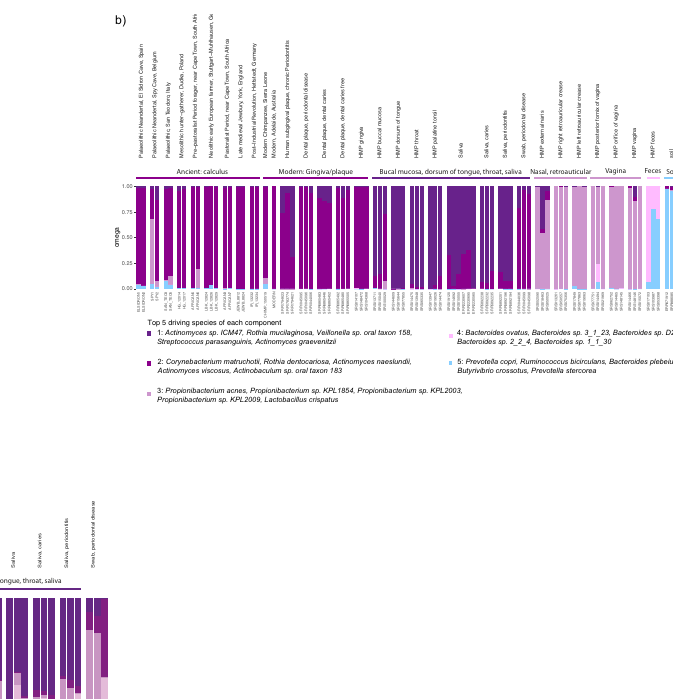
Top 5 driving species of each component 1: Actinomyces sp. ICM47, Veillonella dispar, Actinomyces graevenitzii, Veillonella sp. oral taxon 158, Prevotella sp. ICM33